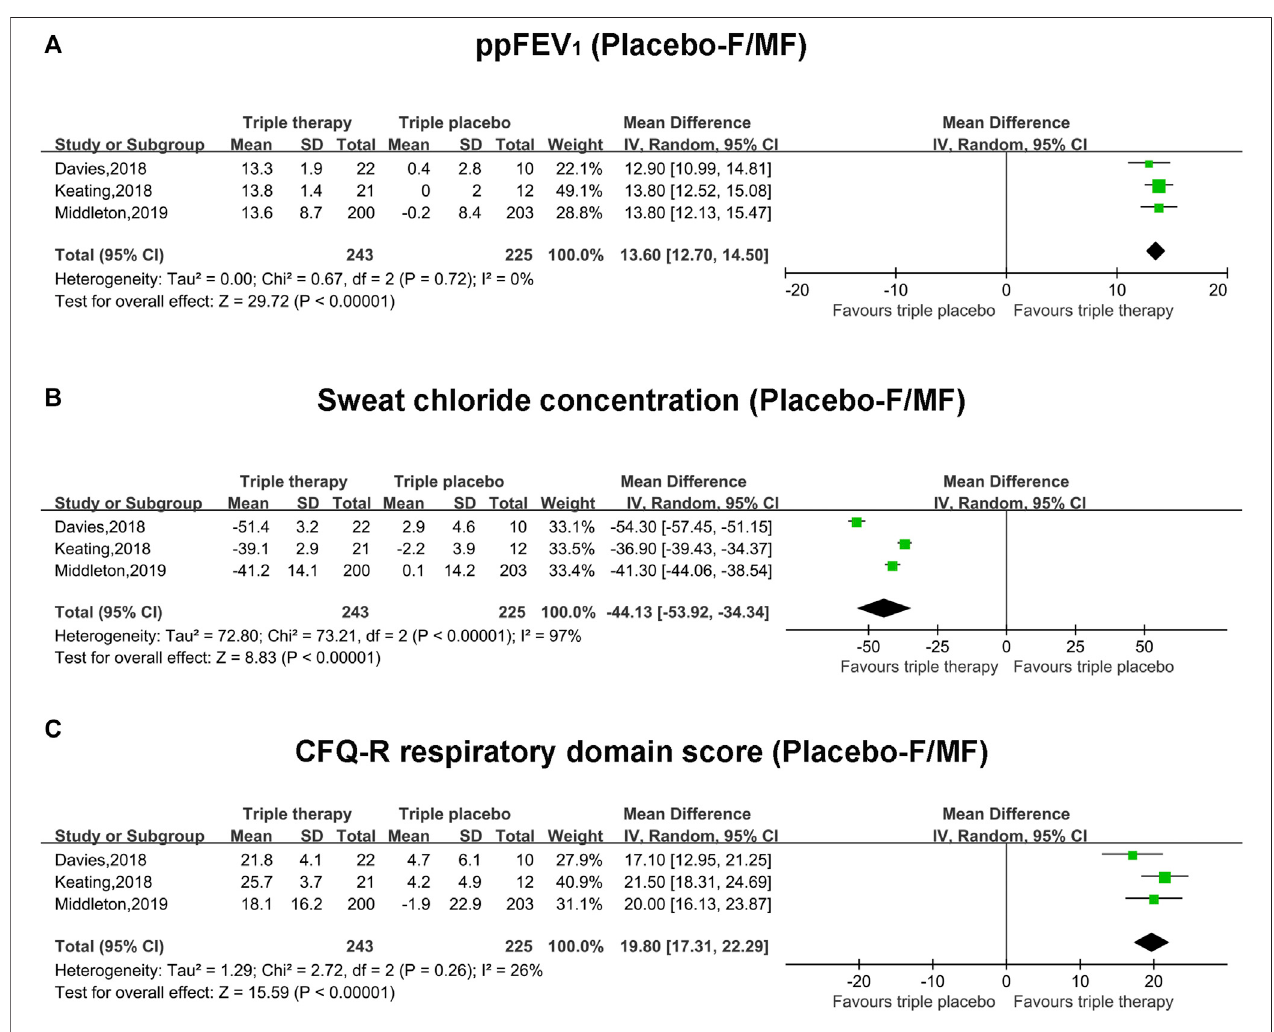
FIGURE 2 | Forest plots of the included studies evaluating the ef fi cacy of triple combination therapy vs. triple placebo with F/MF mutations. (A) ppFEV 1 . (B) Sweat chloride concentration. (C) CFQ-R respiratory domain score.